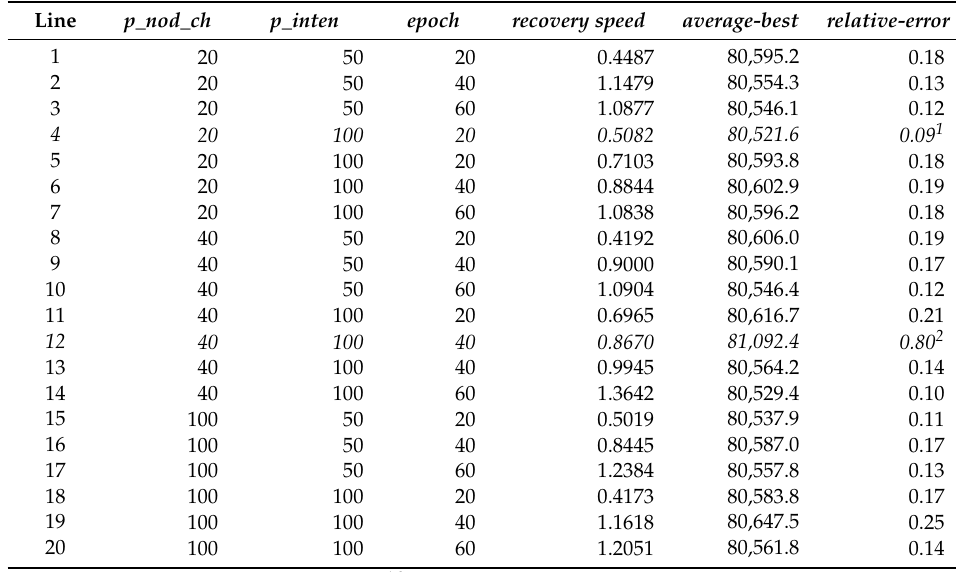
Table 1. Parameters and metrics for d2103 , with ampl =